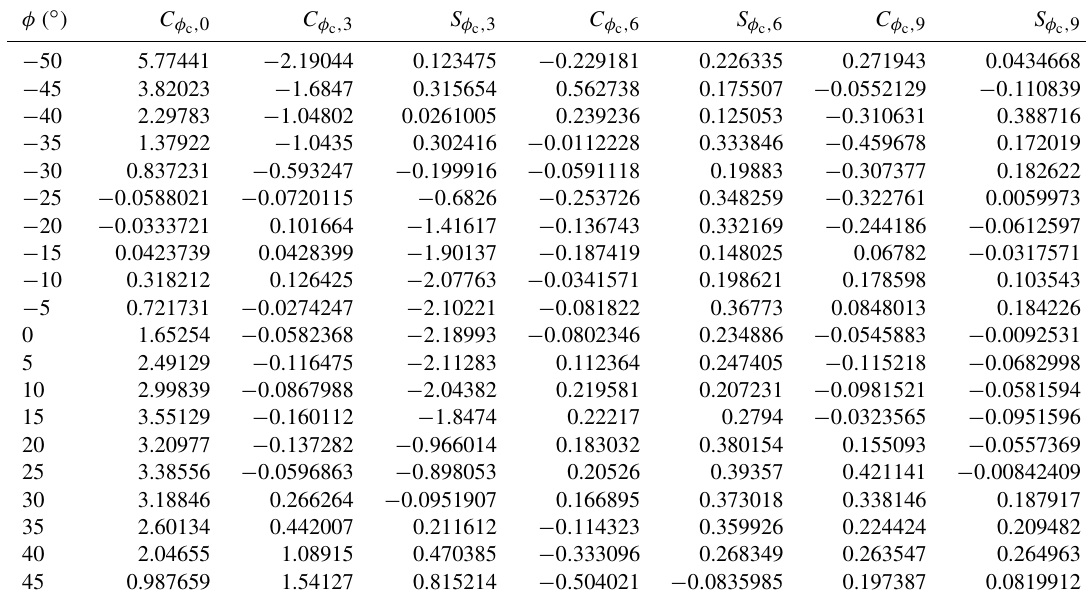
Table A2. LUT for φ c (α,φ)